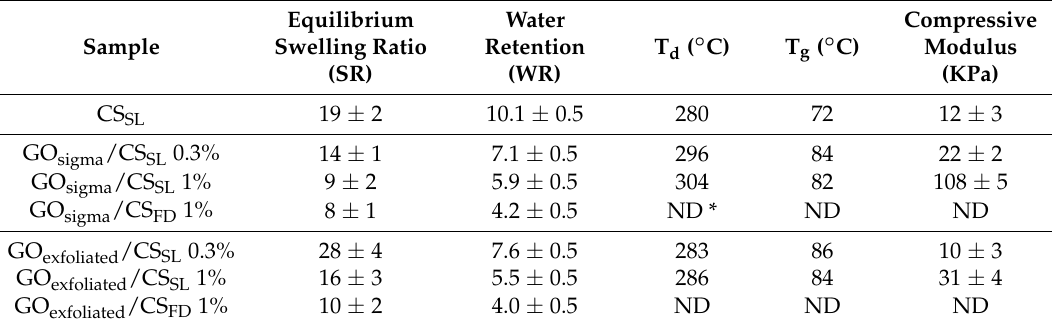
Table 5. Equilibrium swelling ratio (SW), water retention (WR), degradation temperature (T d ) and glass transition temperature (T g ) of chitosan and GO/CS composite scaffolds. Sample